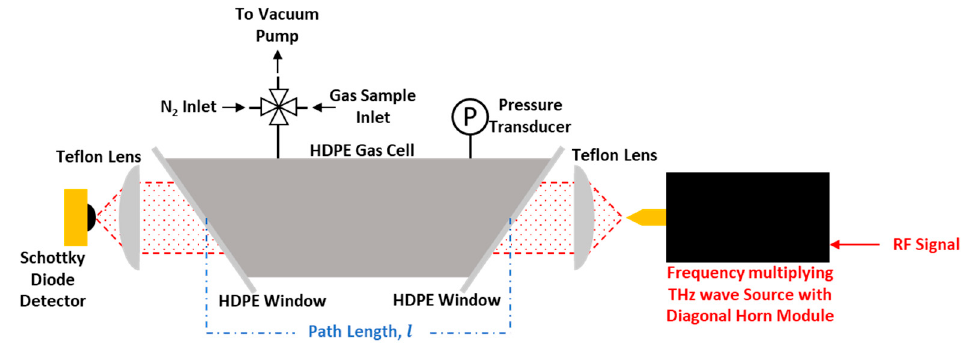
Figure 2. Schematic of the experimental setup.